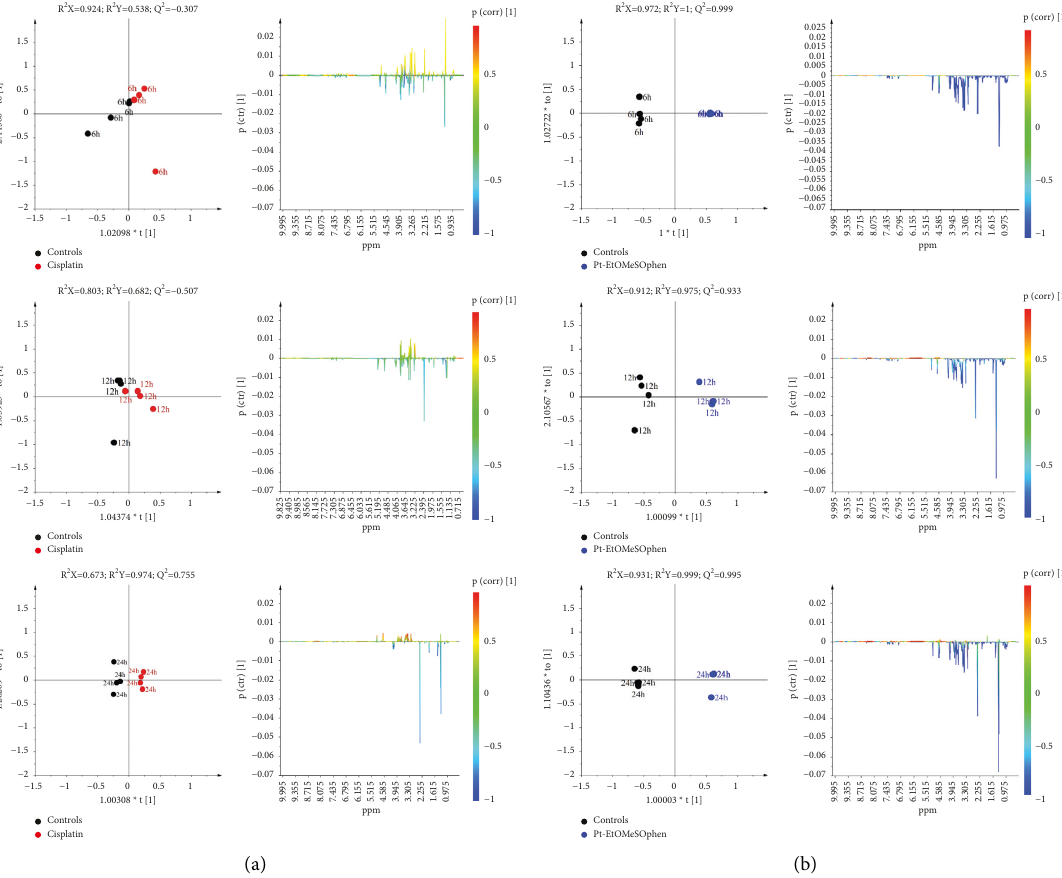
Figure 6: Time response pairwise comparison OPLS-DA score plot models (1+1+0 components) and corresponding color-coded correlation coefficient S-line plots displaying the related predictive discriminant loading variables derived from 1 H NMR spectra of SH- SY5Y cell growth media obtained from different pairwise groups. (a) Controls vs. cisplatin. (b) Controls vs.